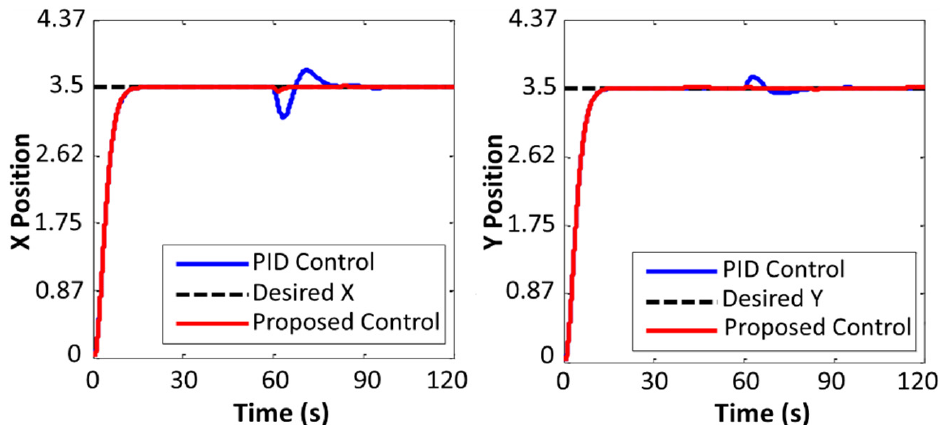
Figure 8. Performance of the quadcopter in tracking the desired X and Y positions.